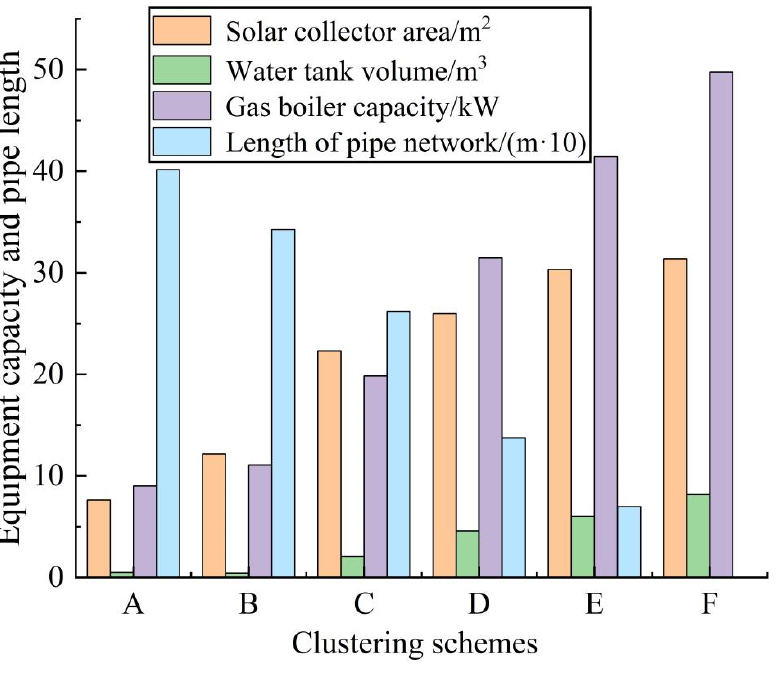
Figure 7. Total equipment capacities of the whole village under different clustering schemes.